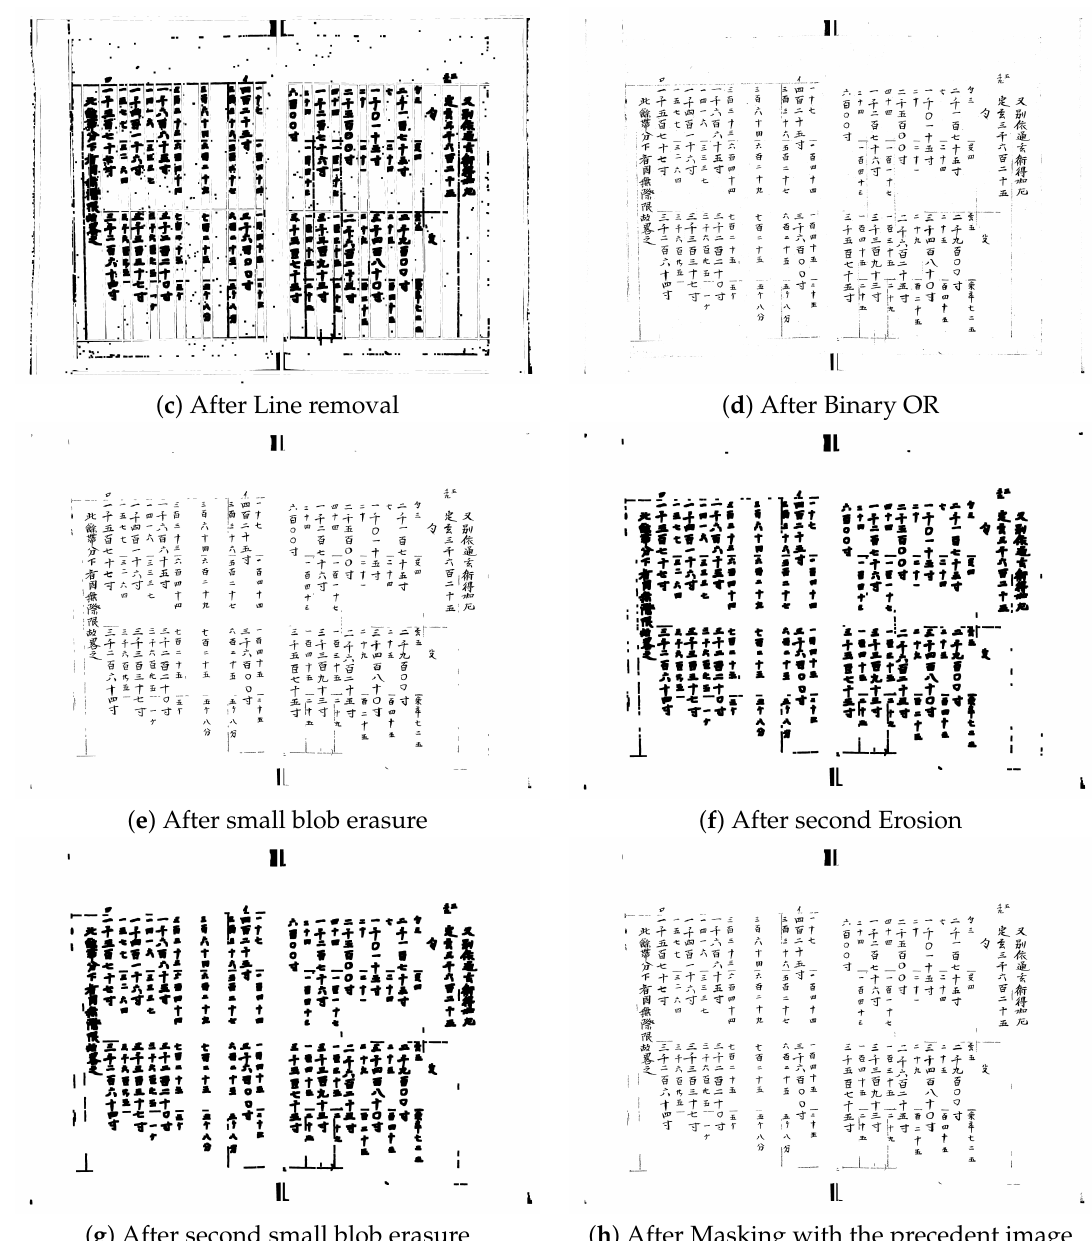
Figure 6. Example of the noise removal